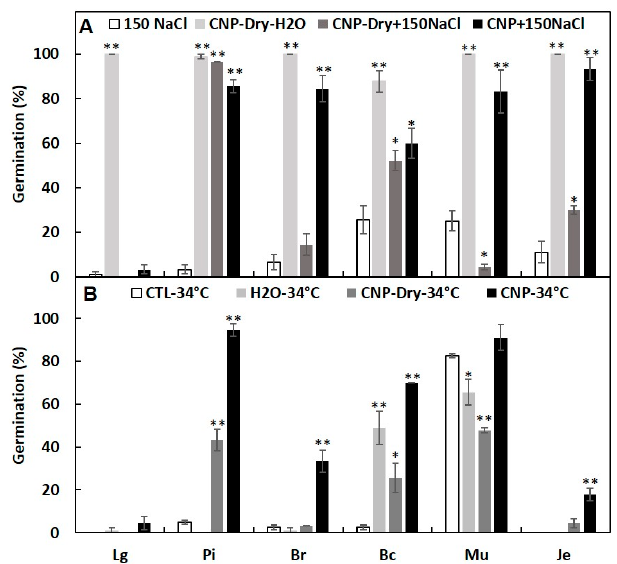
Figure 5. Effects of priming with CNPs on lettuce seed germination. ( A ) Germination of CNPs-treated seeds with (CNP-Dry) or without drying (CNP) in H 2 O or 150 mM NaCl. 150 NaCl: direct germination of seeds without any treatment in 150 mM NaCl. ( B ) Germination of CNPs-treated seeds with (CNP-Dry) or without drying (CNP) in H 2 O at 34 °C. 34 °C-CTL: germination of seeds without any treatment in H 2 O at 34 °C; H 2 O-34 °C: germination of seeds pretreated in H 2 O at 34 °C. * and ** denote the statistical significance compared to 150 NaCl (A) or CTL-34 °C (B) at p < 0.05 and p < 0.01 level, respectively.